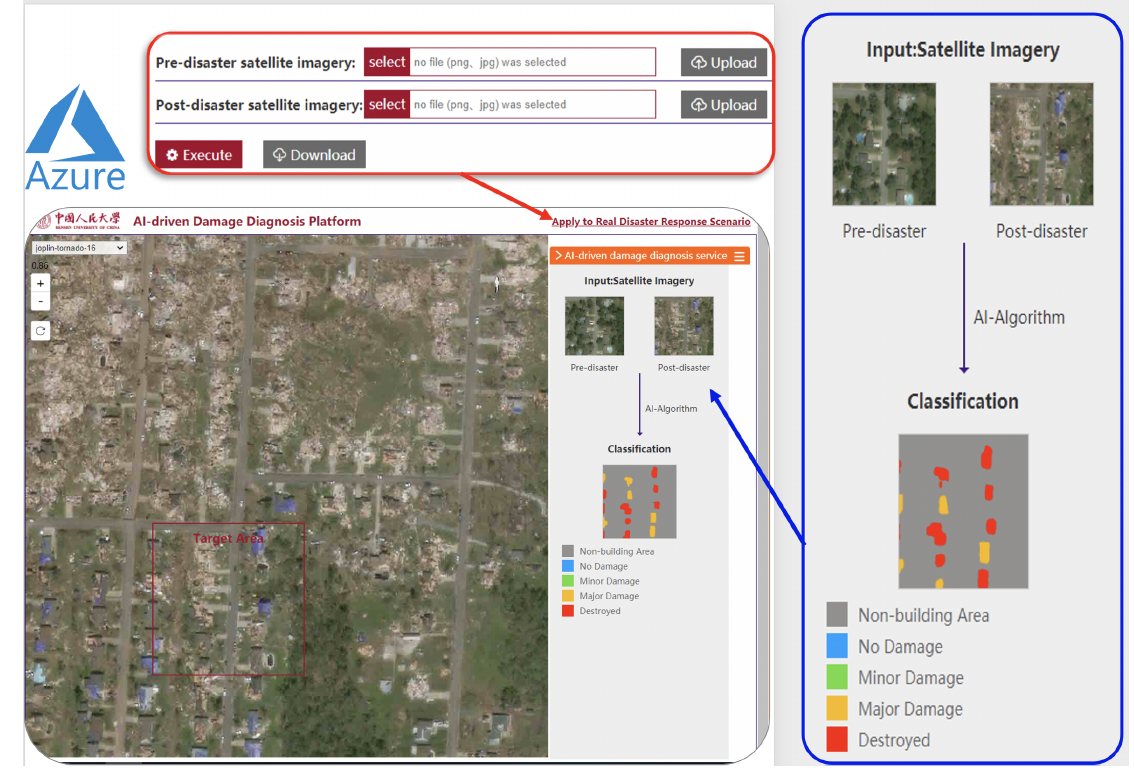
Figure 11. Interface of Cloud-Based AI Damage Mapping Online